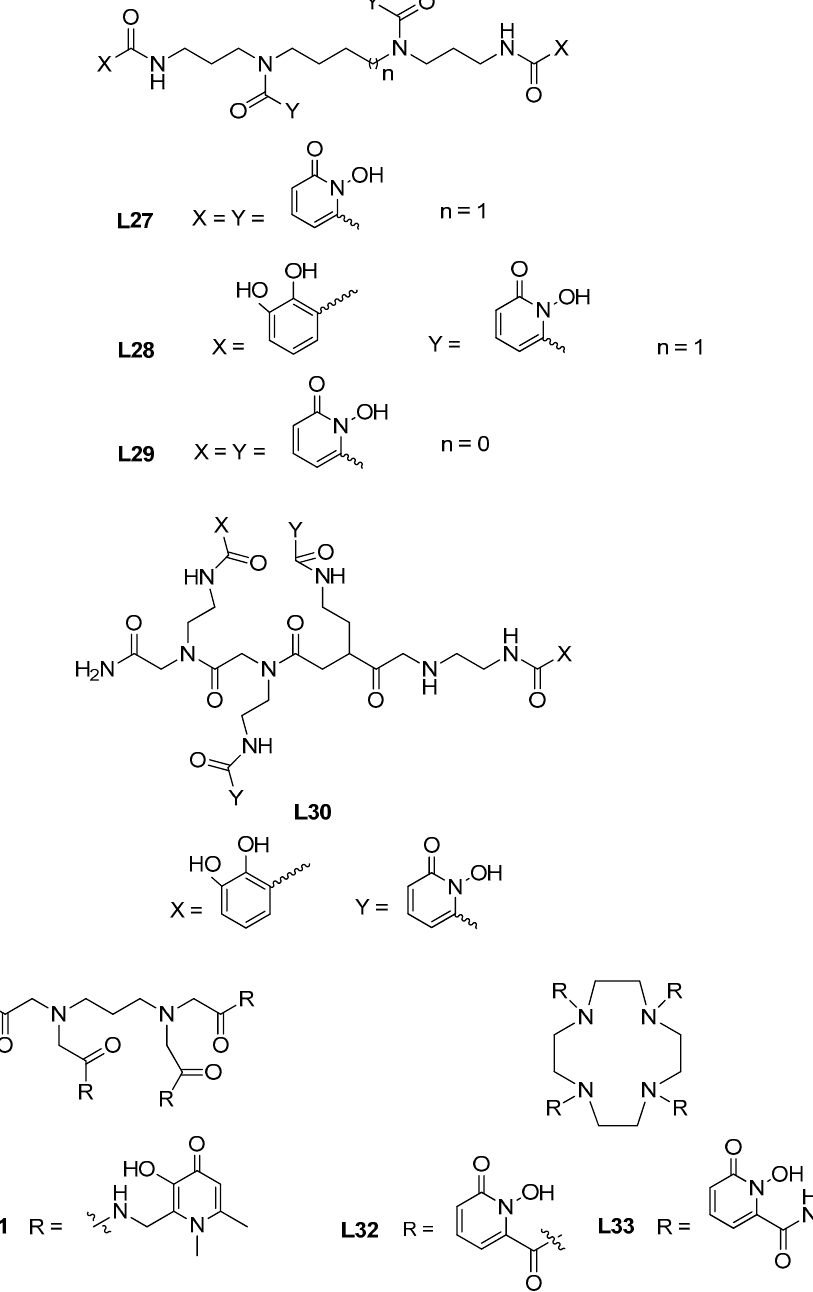
Figure 8. Molecular structure of selected octadentate compounds.